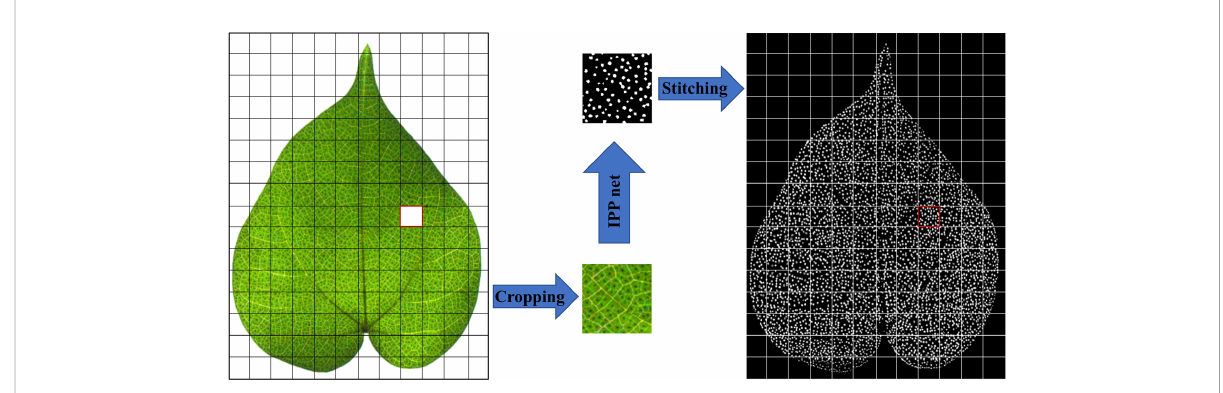
FIGURE 6 Image cropping and stitching. The red box was one of the sub-images, which has been cropped and segmented and then stitched.